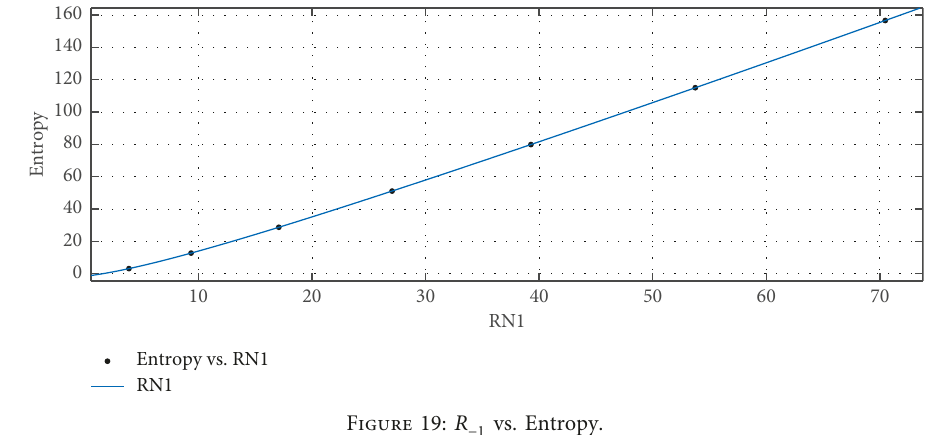
Figure 19: R − 1 vs. Entropy.